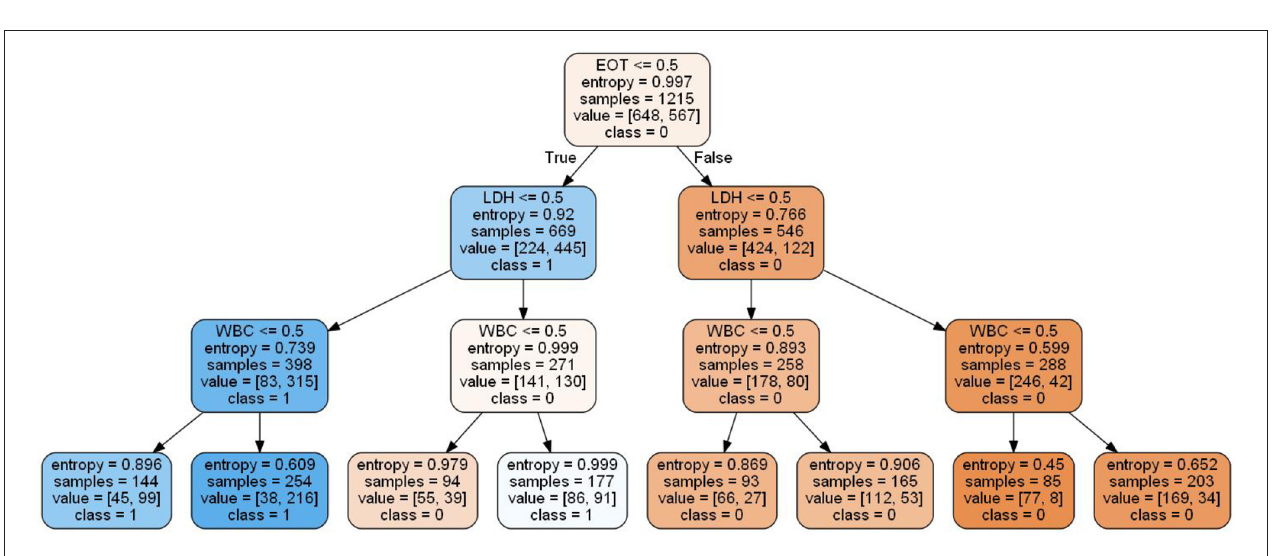
FIGURE 6 | Simplified decision tree model based on the top three